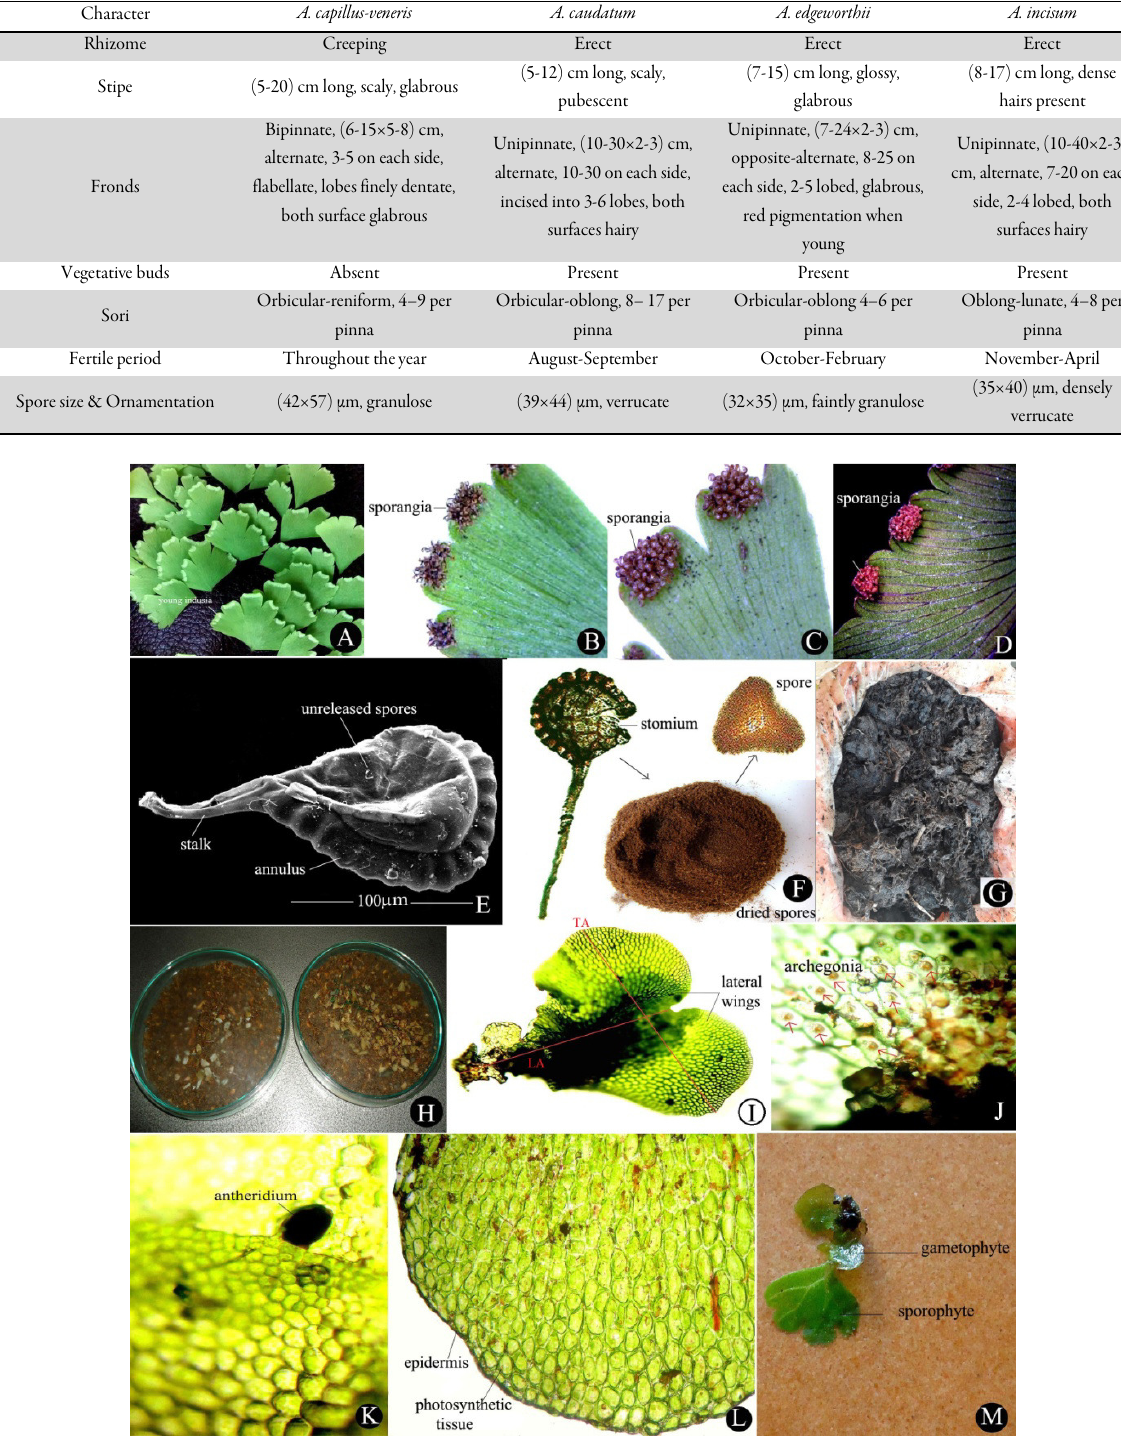
Fig. 1. Sporophytic and gametophytic features in Adiantum . (A) Fertile frond in A. capillus-veneris (B) Pinna of A. caudatum (C) Pinna of A. incisum (D) Pinna of A. edgeworthii (E) Sporangium in A. capillus-veneris before dehiscence (F) Typical sporangium in Adiantum for dehiscence with stomium, dried spores and a single spore (G) Dead Wood of Tree Fern (H) Petridish with media for spore sowing (I - K) Prothallus of A. capillus-veneris with sex organs - archegonia & antheridia (L - M) One celled thick parenchymatous cells in gametophyte & chimera of sporophyte and gametophyte in A.